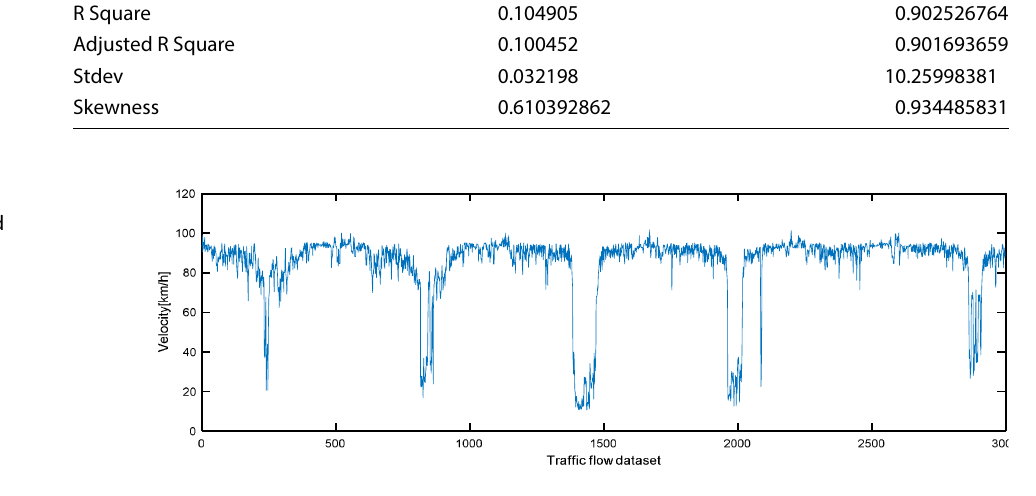
Fig. 14 Comparison between CDS and